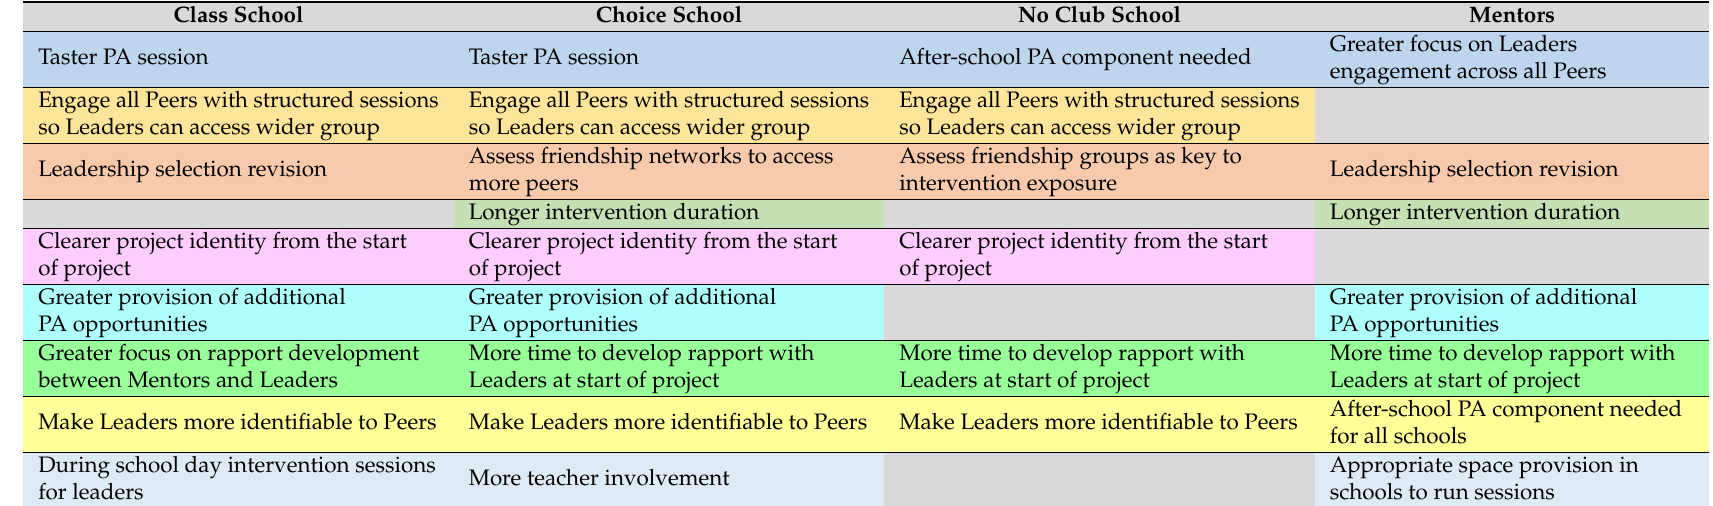
Table 2. Refinements to G-PACT intervention based on the thematic analysis, presented by school and mentor